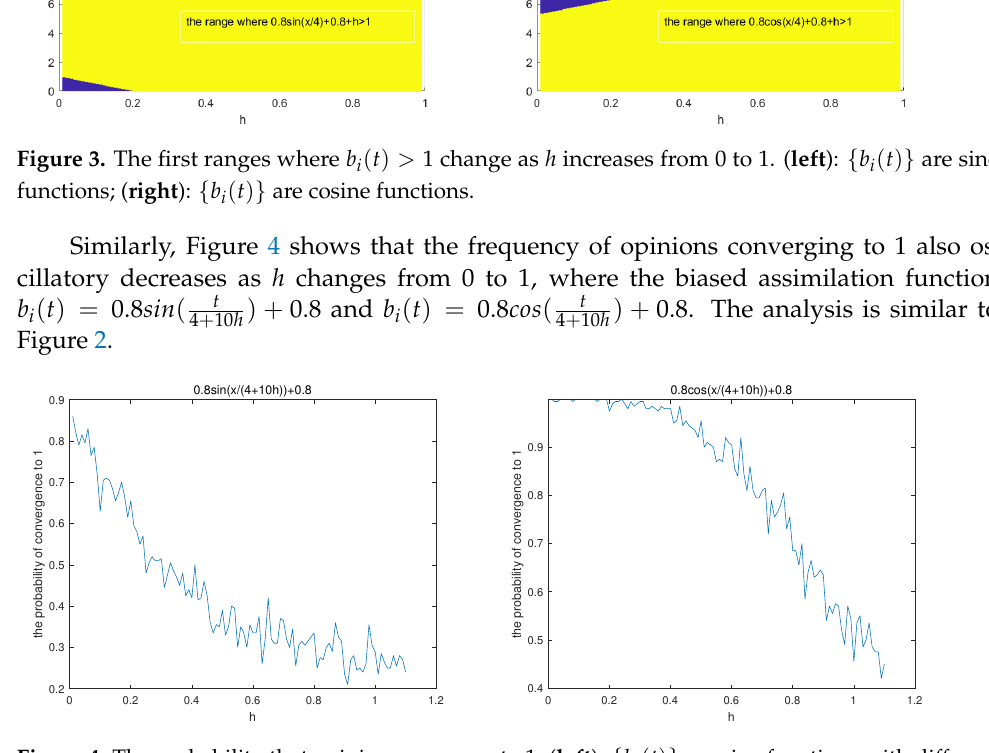
Figure 4. The probability that opinions converge to 1. ( left ): { b i ( t ) } are sine functions with different periods; ( right ): { b i ( t ) } are cosine functions with different periods. (2) Probability of consensus for exponential functions of b i ( t ) : In this part, the proba- bilities of opinion consensus to 0 or 1 for the model (1) are